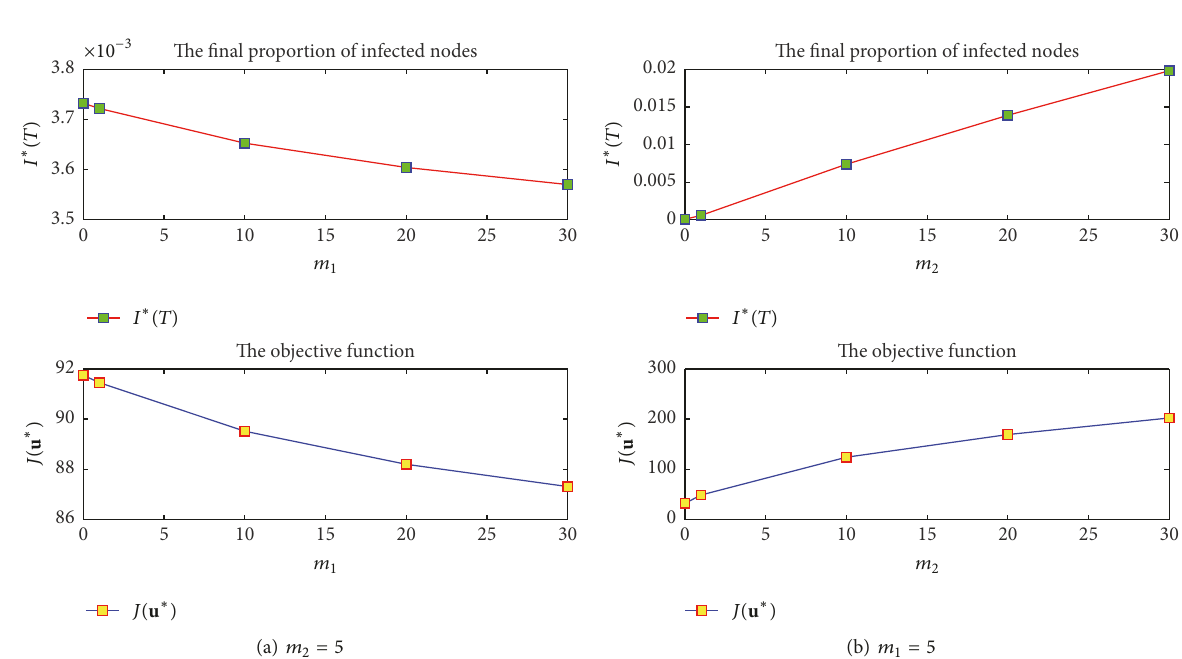
Figure 15: 𝐼 ∗ (𝑇) and 𝐽( u ∗ ) for different 𝑚 1 and 𝑚 2 for Example